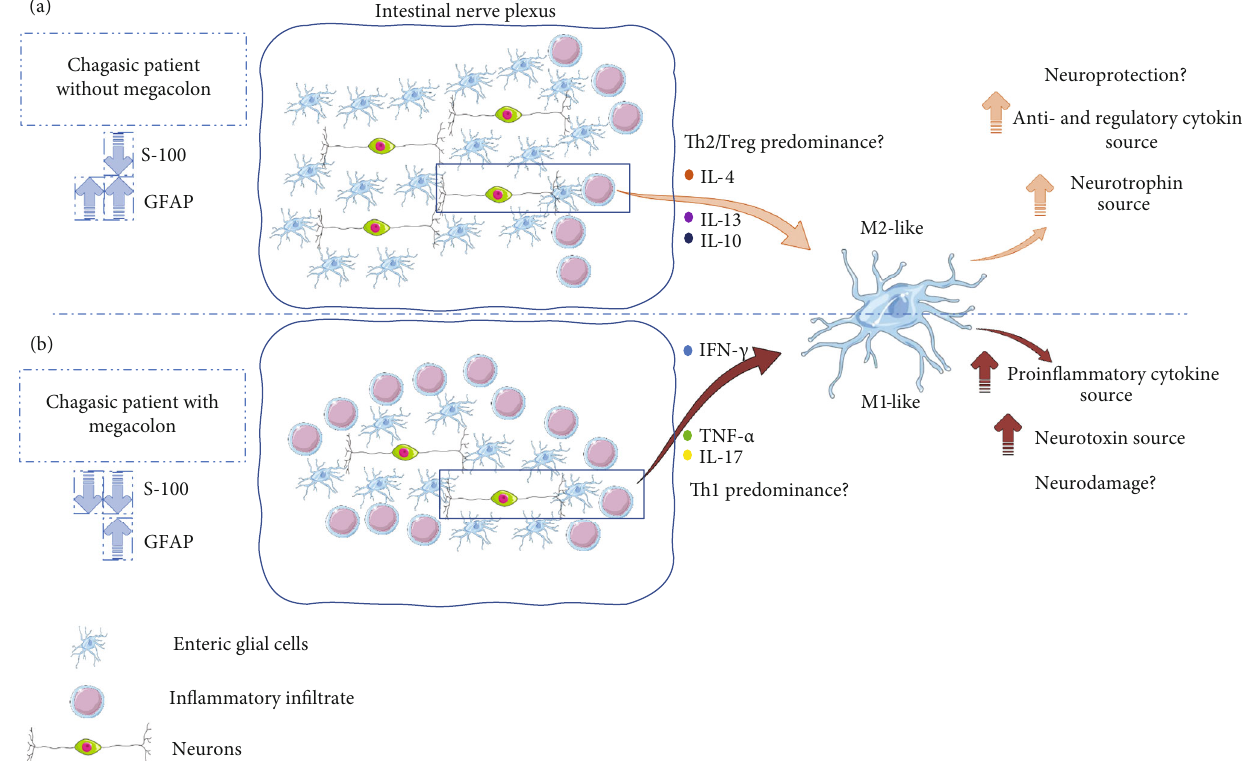
Figure 1: Hypothetical scheme of the di ff erential behavior of enteric glial cells in the intestine of infected patients without megacolon (a) and with megacolon (b). This work, “ Hypothetical scheme of the di ff erential behavior of enteric glial cells in the intestine of infected patients without megacolon (a) and with megacolon (b), ” is a derivative of “ Servier Medical Art ” by Servier, used under CC BY